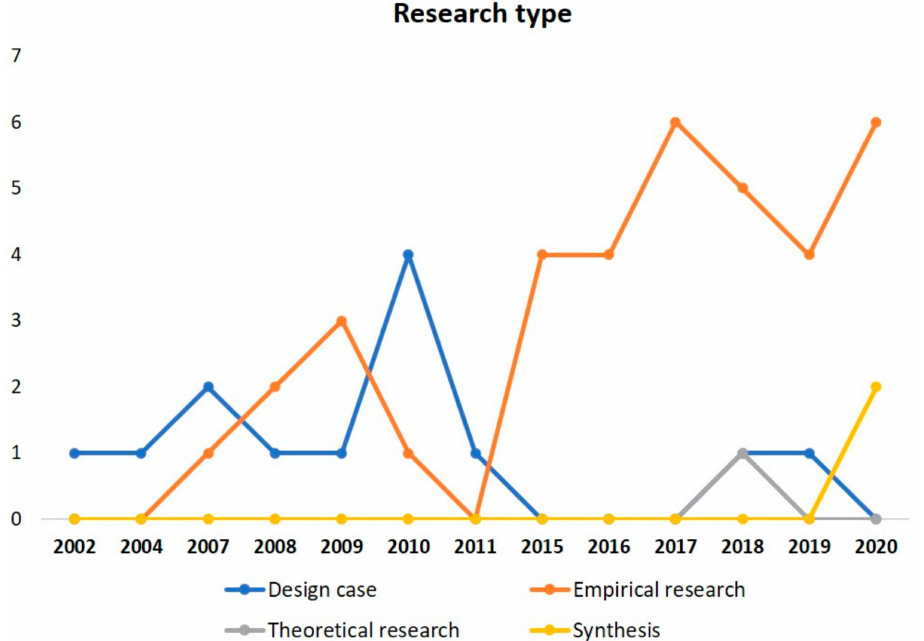
Figure 3. Research type of all AR-supported research in professional training from 2001 to